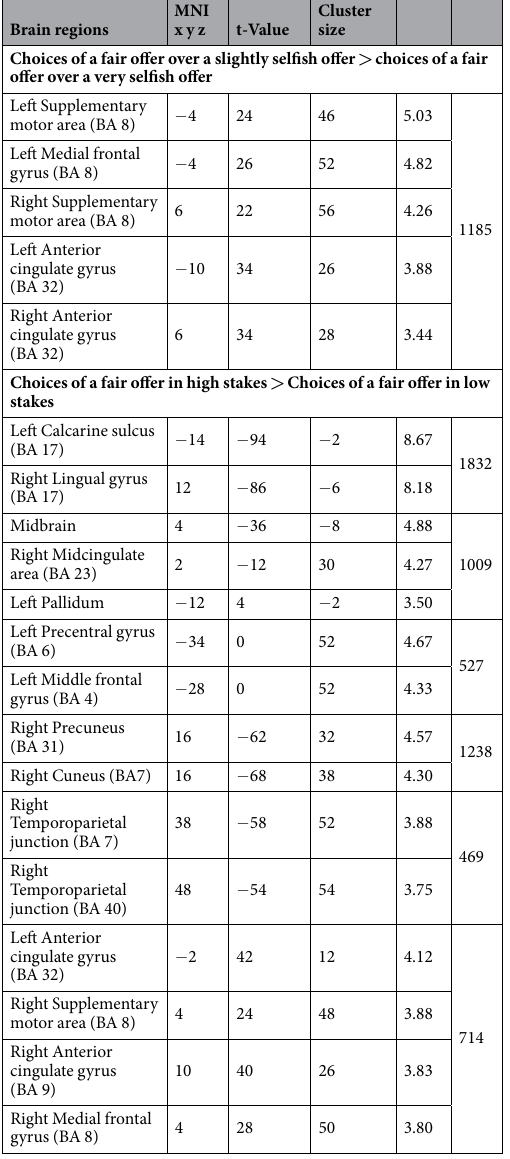
Table 1. Brain regions showing greater activation in choices of a fair offer over a slightly selfish offer (i.e., offering 40% or 30%) than the same choices over a very selfish offer (i.e., offering 20% or 10%); and in choices of a fair offer in higher stakes thank low stakes ( p < 0.001 uncorrected with FDR correction at the cluster level; BA, Brodmann’s